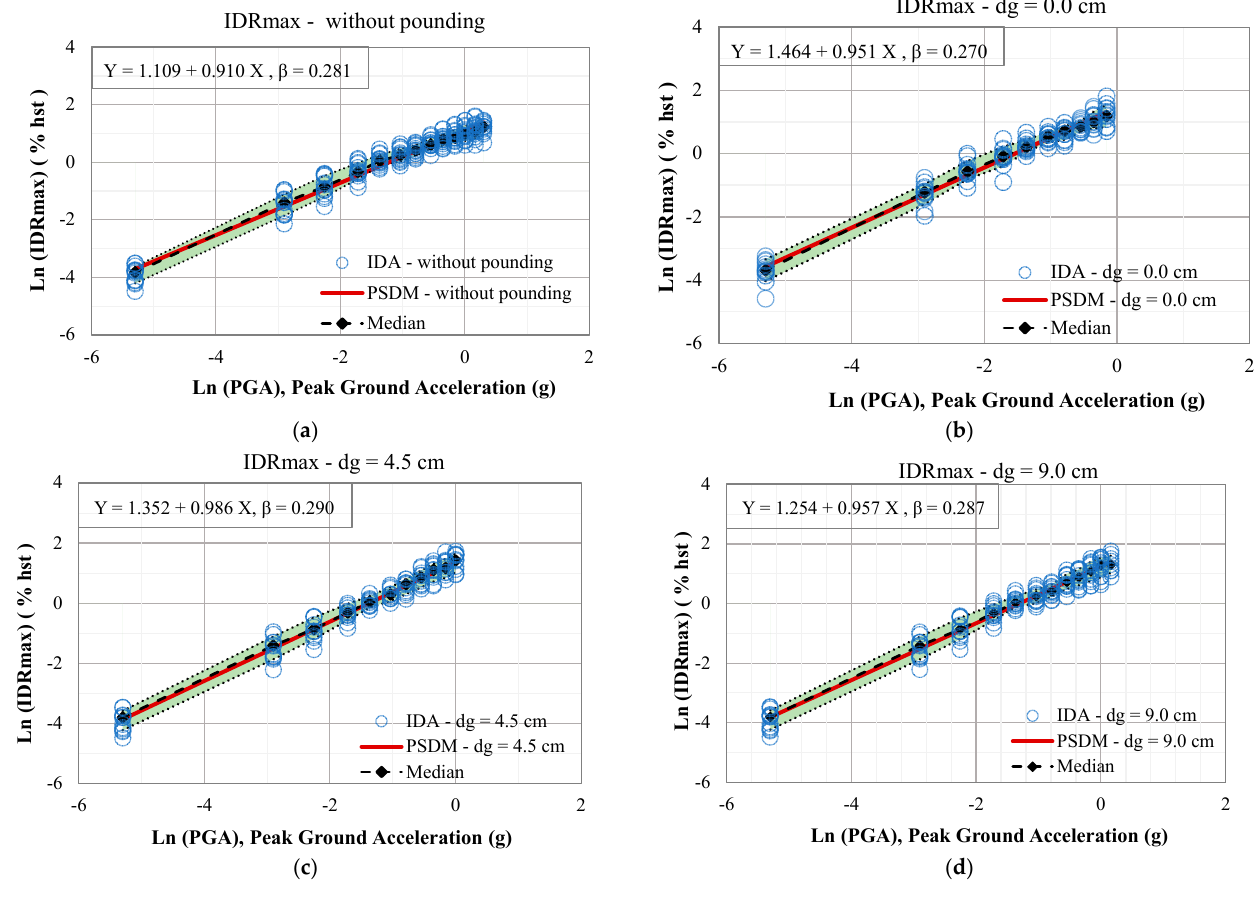
Figure 9. Comparative results in terms of IDR max (%h st ) at each level of PGA as deduced based on IDAs, PSDMs, and median values of demand. Examined cases: ( a ) without the pounding effect, ( b ) d g = 0.0 cm, ( c ) d g = 4.5 cm, and ( d ) d g = 9.0 cm.